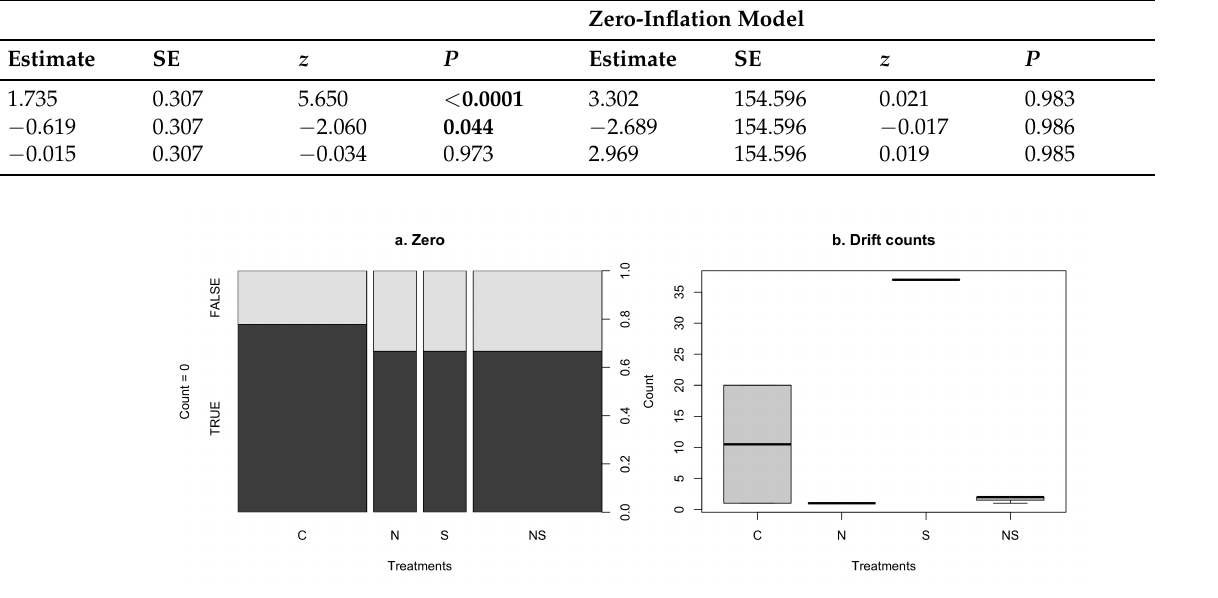
Figure 5. Plots representing the impact of the stressor treatments on the frequency of zeros ( a ) and log-transformed counts ( b ) of individuals from the orders Ephemeroptera, Plecoptera, and Trichoptera drifting out of the first-order channels on day 22. Letter notation for the treatments is consistent with Figure